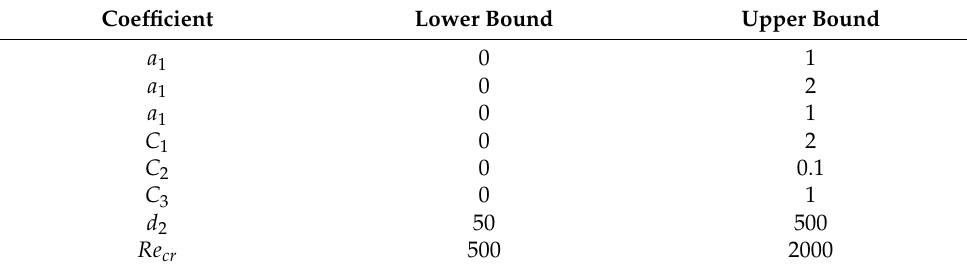
Table 2. Lower and upper bounds of a 1 , a 2 , a 3 , C 1 , C 2 , C 3 , d 2 , Re cr